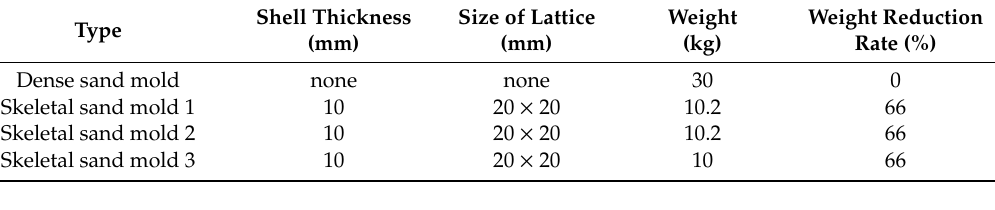
Table 2. Comparison of skeletal molds and the traditional mold.